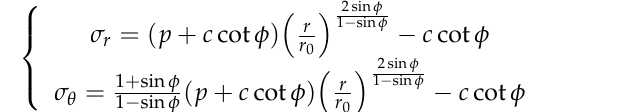
where σ e is the radial stress of the elastic-plastic boundary, σ e = ( 1 − sin φ ) σ 0 and σ 0 is the far-field